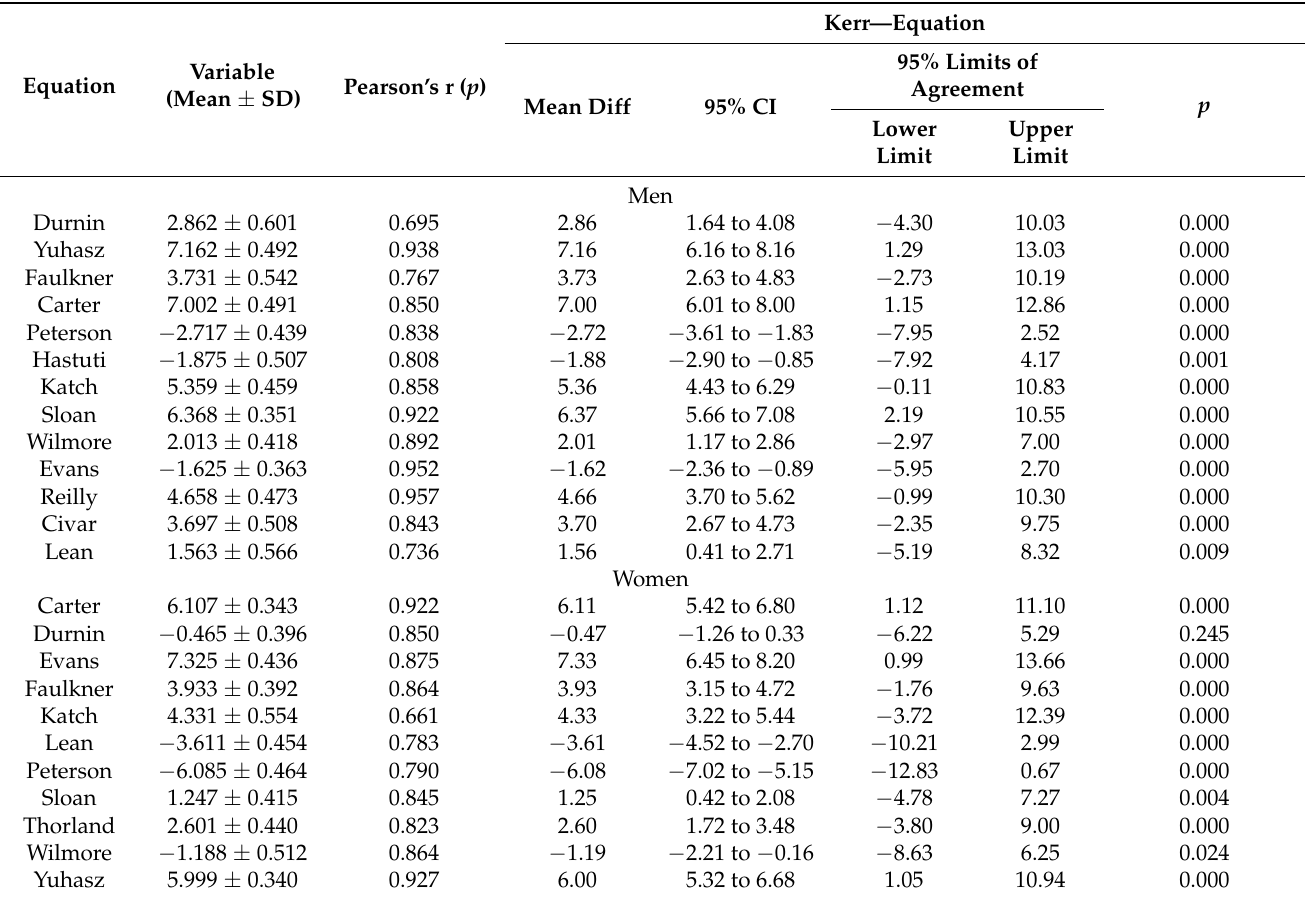
Table 7. Inter-formula comparison for lipid percentage estimation in men and